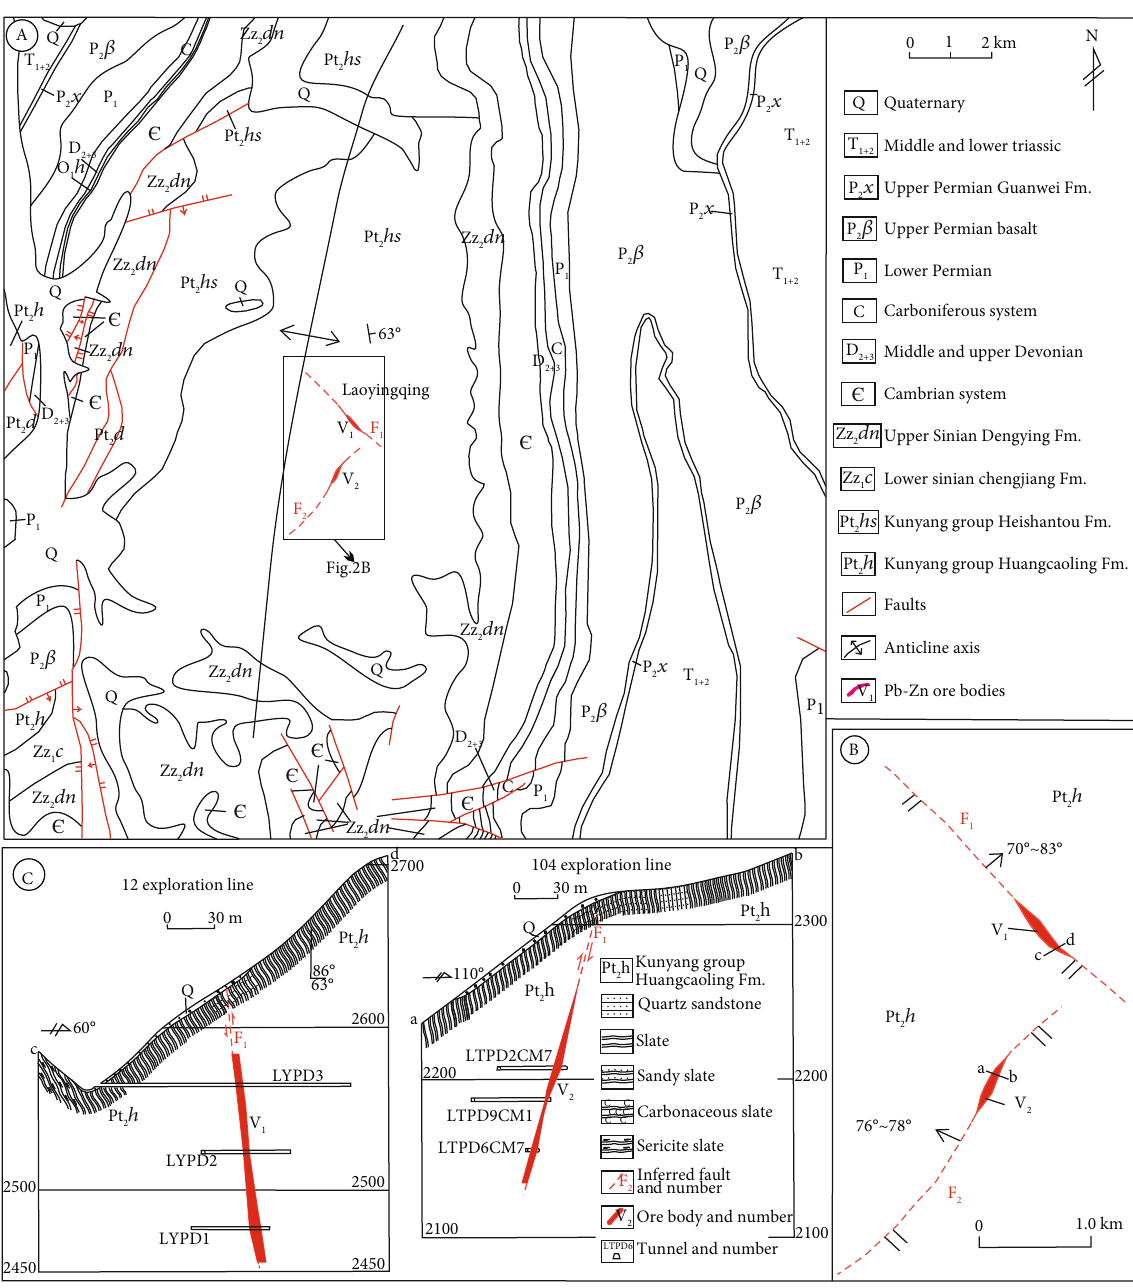
Figure 2: Geological map of the Laoyingqing Pb – Zn deposit. (a) Geological map of mining area. (b) Simpli fi ed geological map of the deposit. (c) Geological section of exploration line 12 of Laoyingqing ore block and Geological section of exploration line 104 of Laolongtian ore